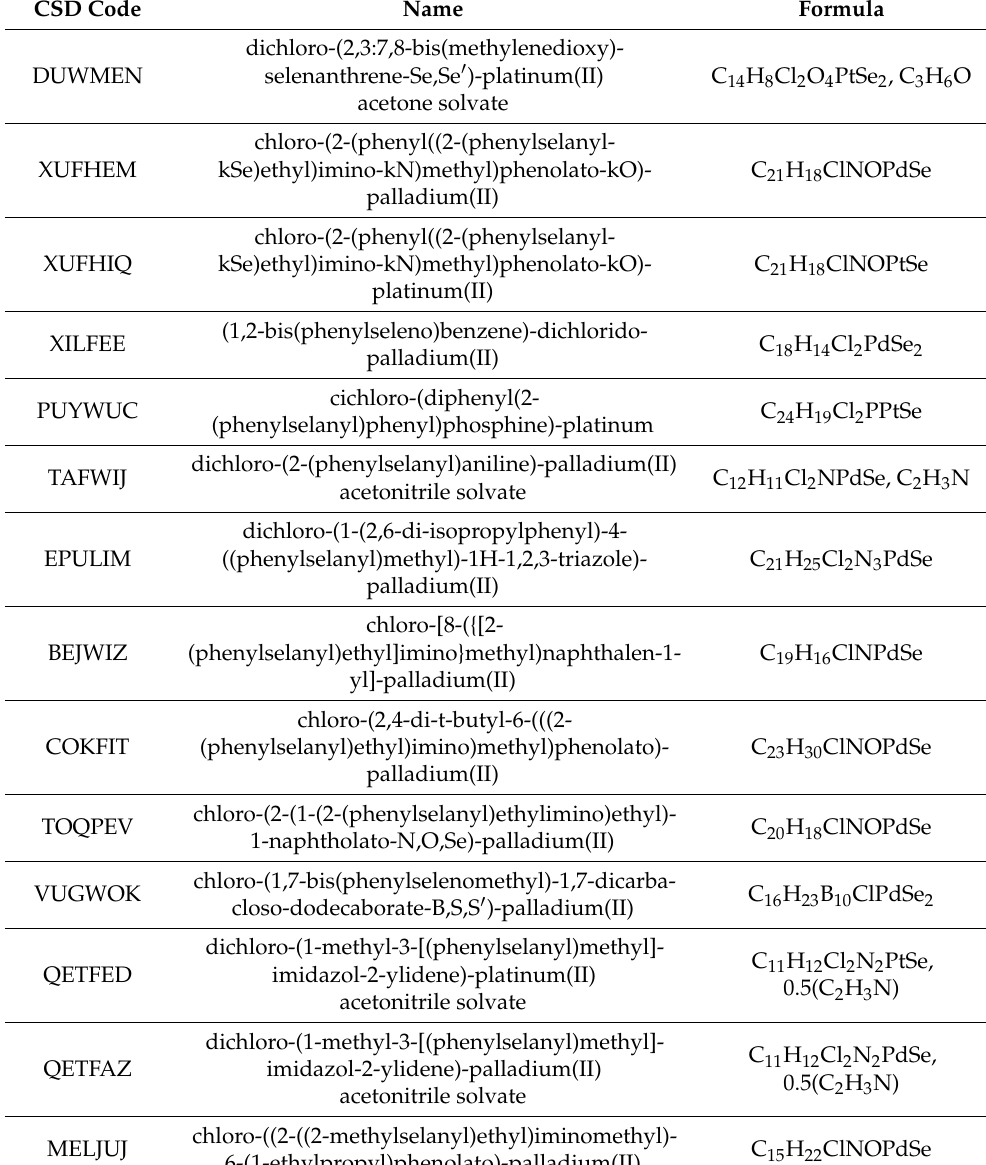
Table 2. List of CSD codes, compound names and formulas of the Se involving dimers. CSD